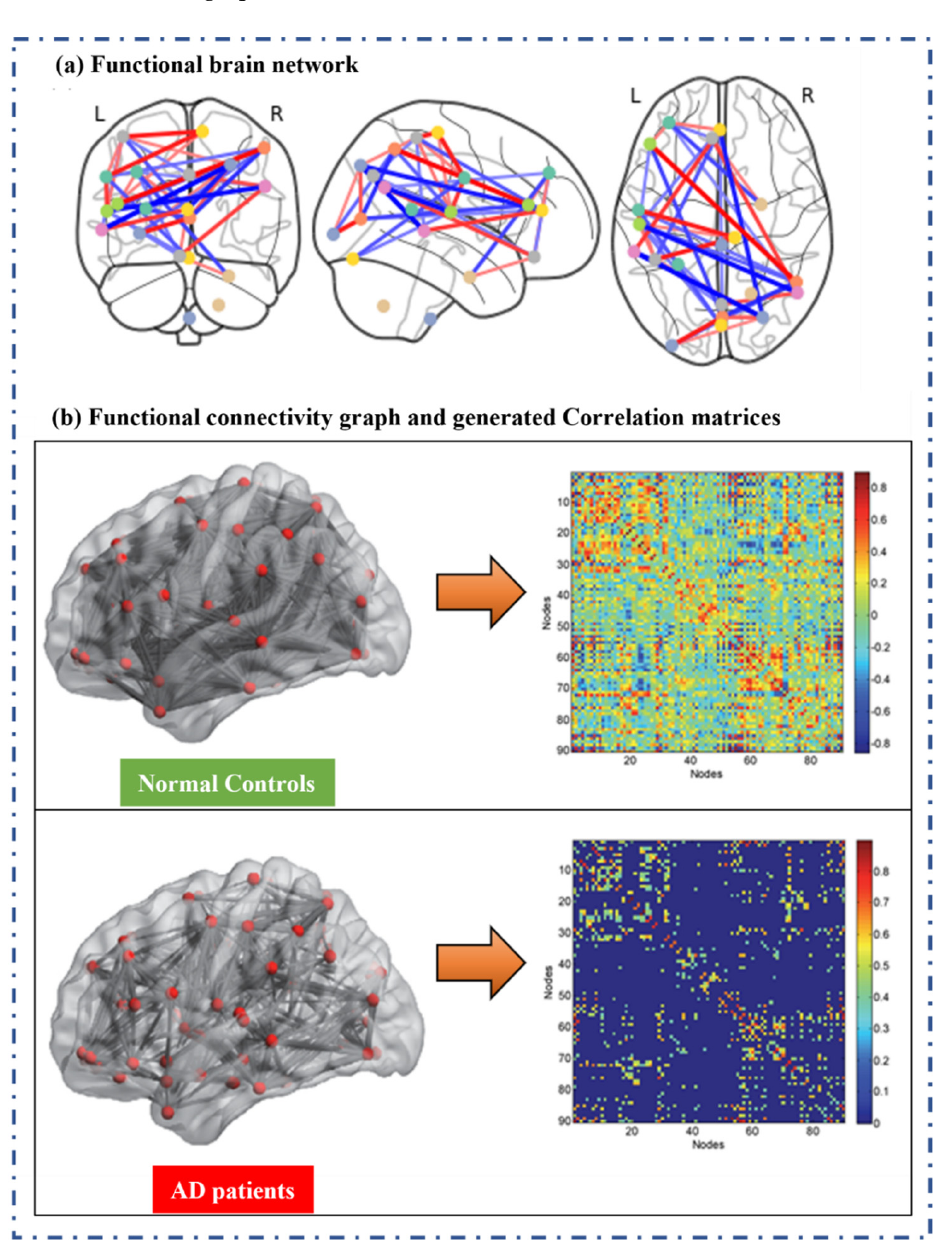
Figure 6. ( a ) Brain Network graph where nodes denote the voxel/ROI across the brain and edges denotes their functional connections ( b ) Graph-based estimation of correlation matrices for NCs and AD patients. The correlation matrices demonstrate the weaker/absent correlation in AD patients compared to NC.